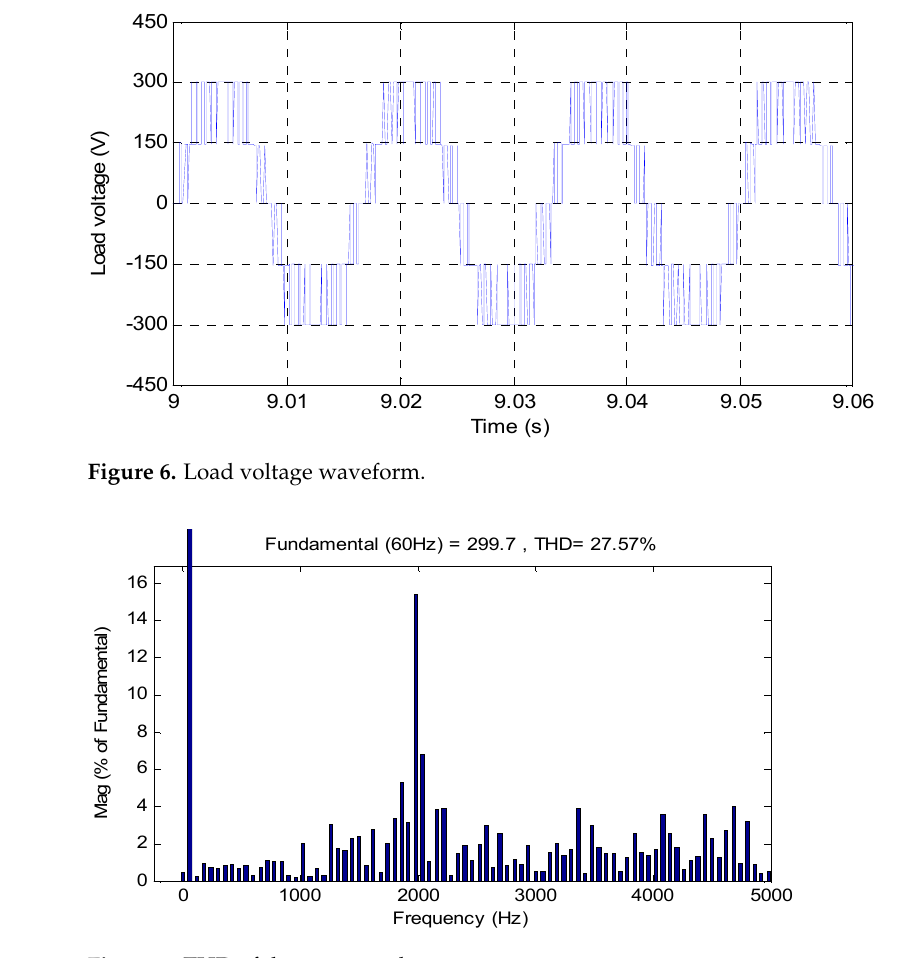
Figure 7. THD of the output voltage.